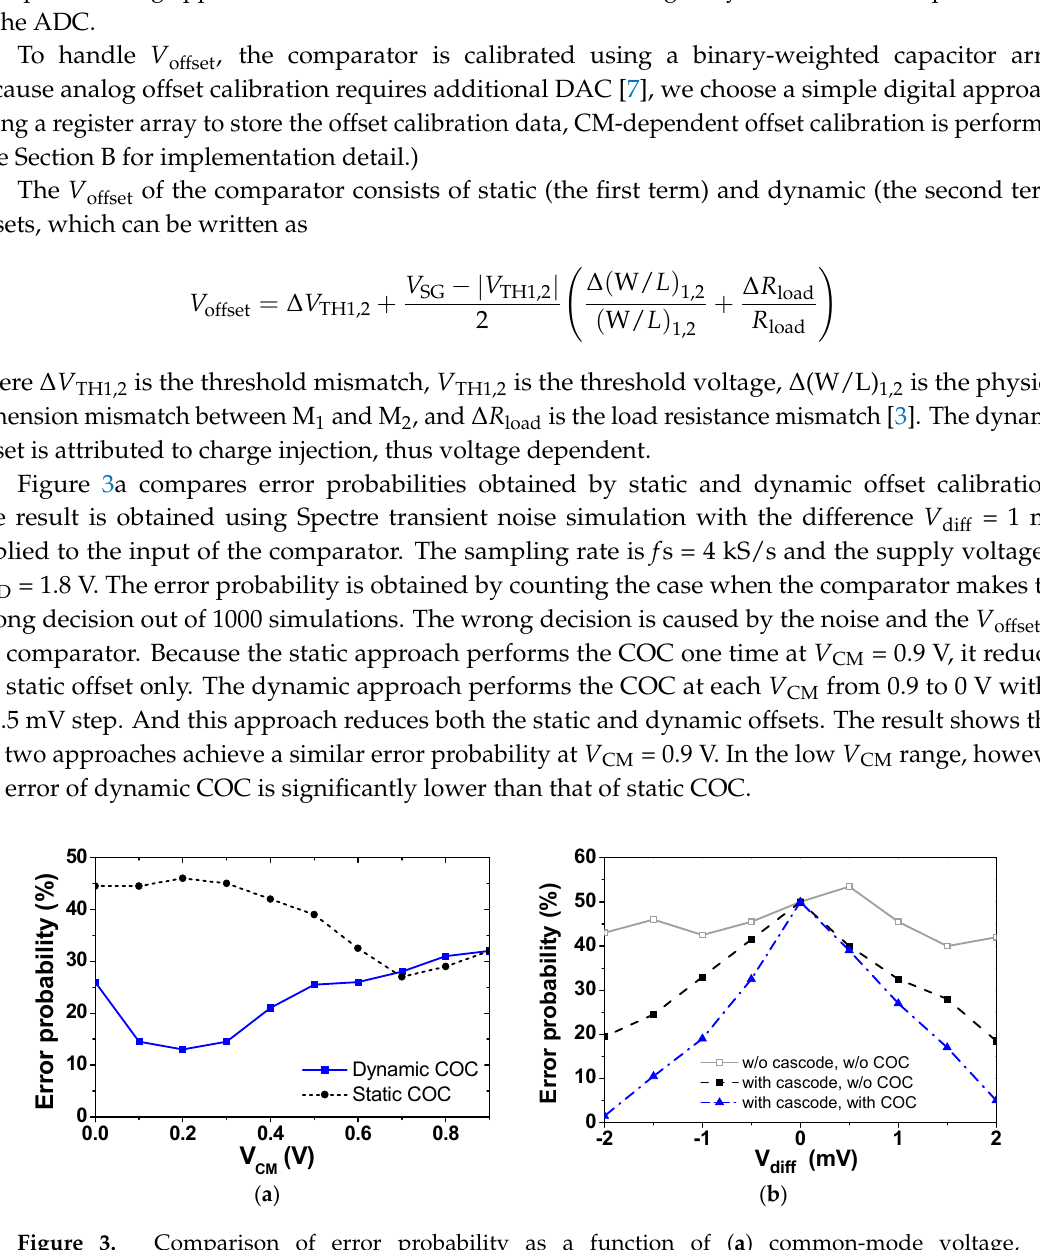
Figure 3. Comparison of error probability as a function of ( a ) common-mode voltage, ( b ) input difference.